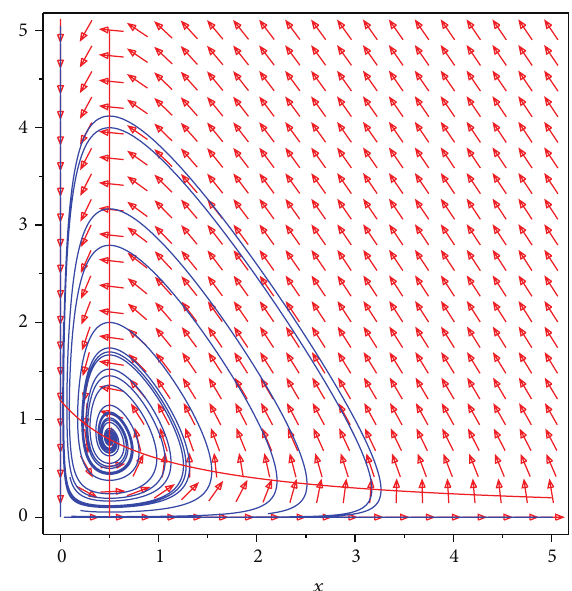
Figure 2: Vector graph of system (7) with a stable focus, where 𝑟 = 0.6 , 𝑎 = 1 , 𝑏 = 0.5 , 𝑐 = 0.8 , and 𝑑 = 0.4 .